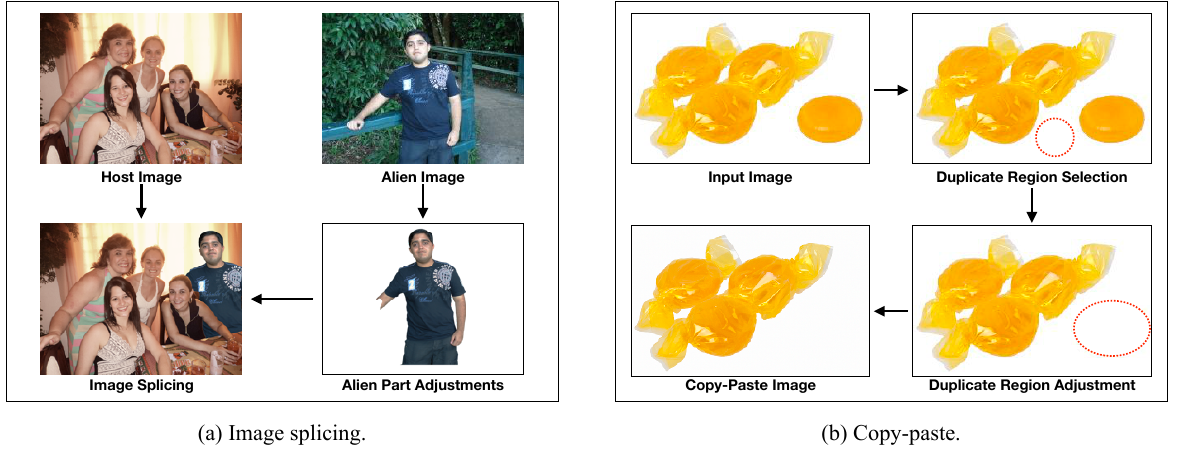
Figure 1 - Simplified scheme of the image forgery process: ( a ) image splicing creation, and ( b ) copy-paste image creation.